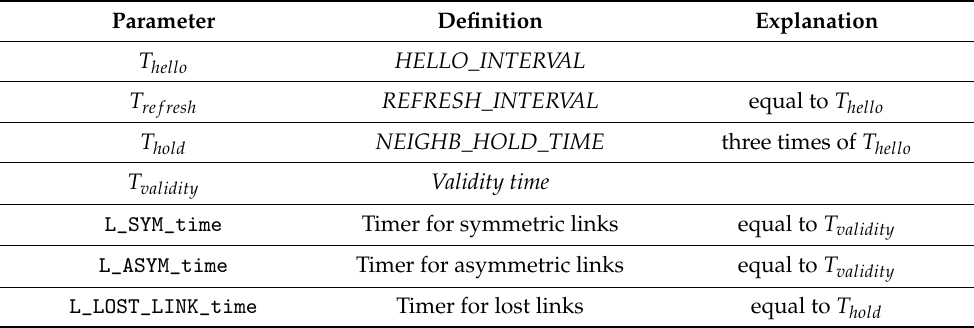
Table 2. OLSR time